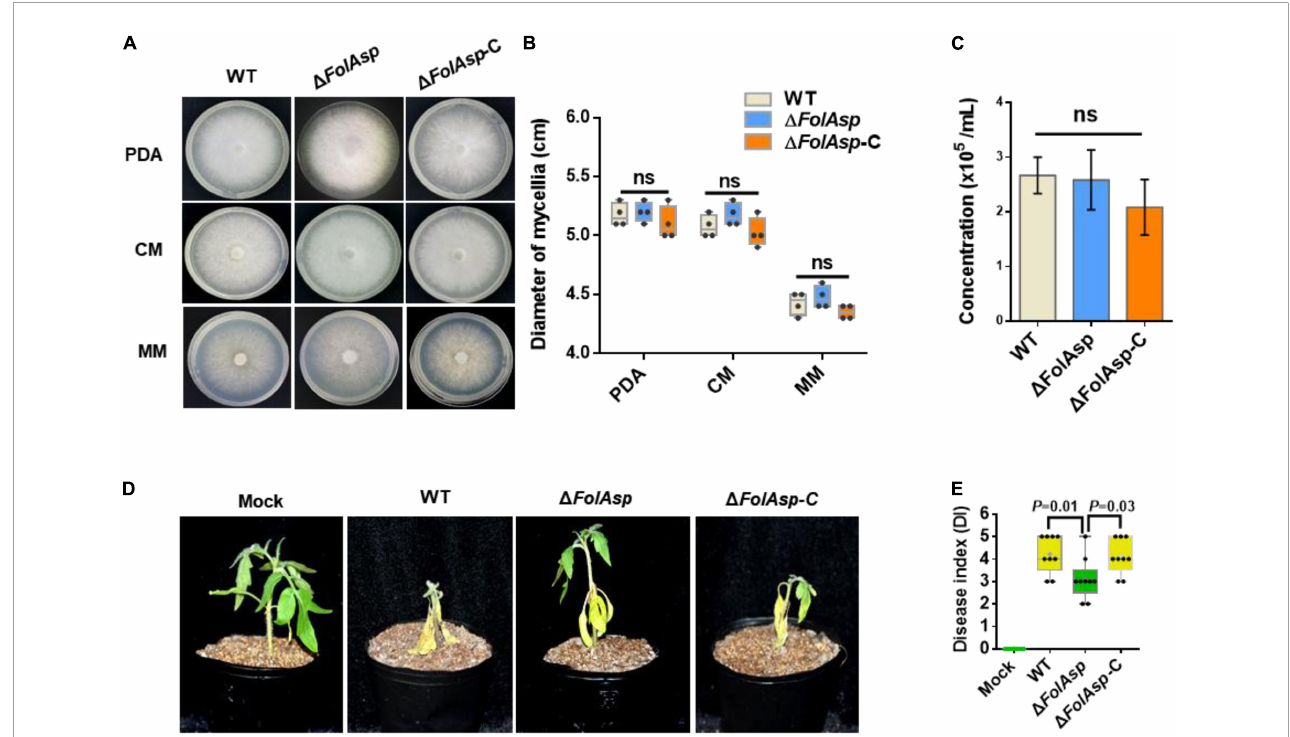
FIGURE2 Phenotypic analysis of FolAsp mutant strains. (A) Mycelial growth of the WT and (cid:49) FolAsp ( (cid:49) FolAsp -KO10) mutant strains on the indicated plates after 5 days of cultivation. (B) Mycelium diameters of colonies of the strains in panel (A) were measured at 5 days of cultivation. (C) Conidia production of the WT and (cid:49) FolAsp mutant strains in PDB liquid medium at the indicated times. No significant difference (ns) was indicated according to multiple t -test. (D) Virulence of the wild-type (WT) and FolAsp mutant strains on tomato. The disease symptoms were observed, and photographs were taken at 14 days after inoculation (DAI). Mock, inoculation with water. Experiments were repeated three times with similar results. (E) Disease index scored at 14 DAI. Significant differences were determined according to one-way ANOVA, and p value was shown. For panels (B,E) whiskers of the boxplots display the upper and lower quartiles, the boxes display the interquartile range, and the plus displays the